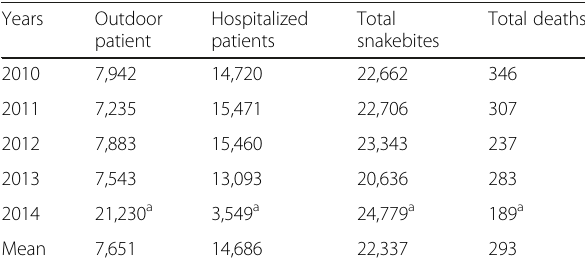
Table 2 Snakebite distribution according to the severity,